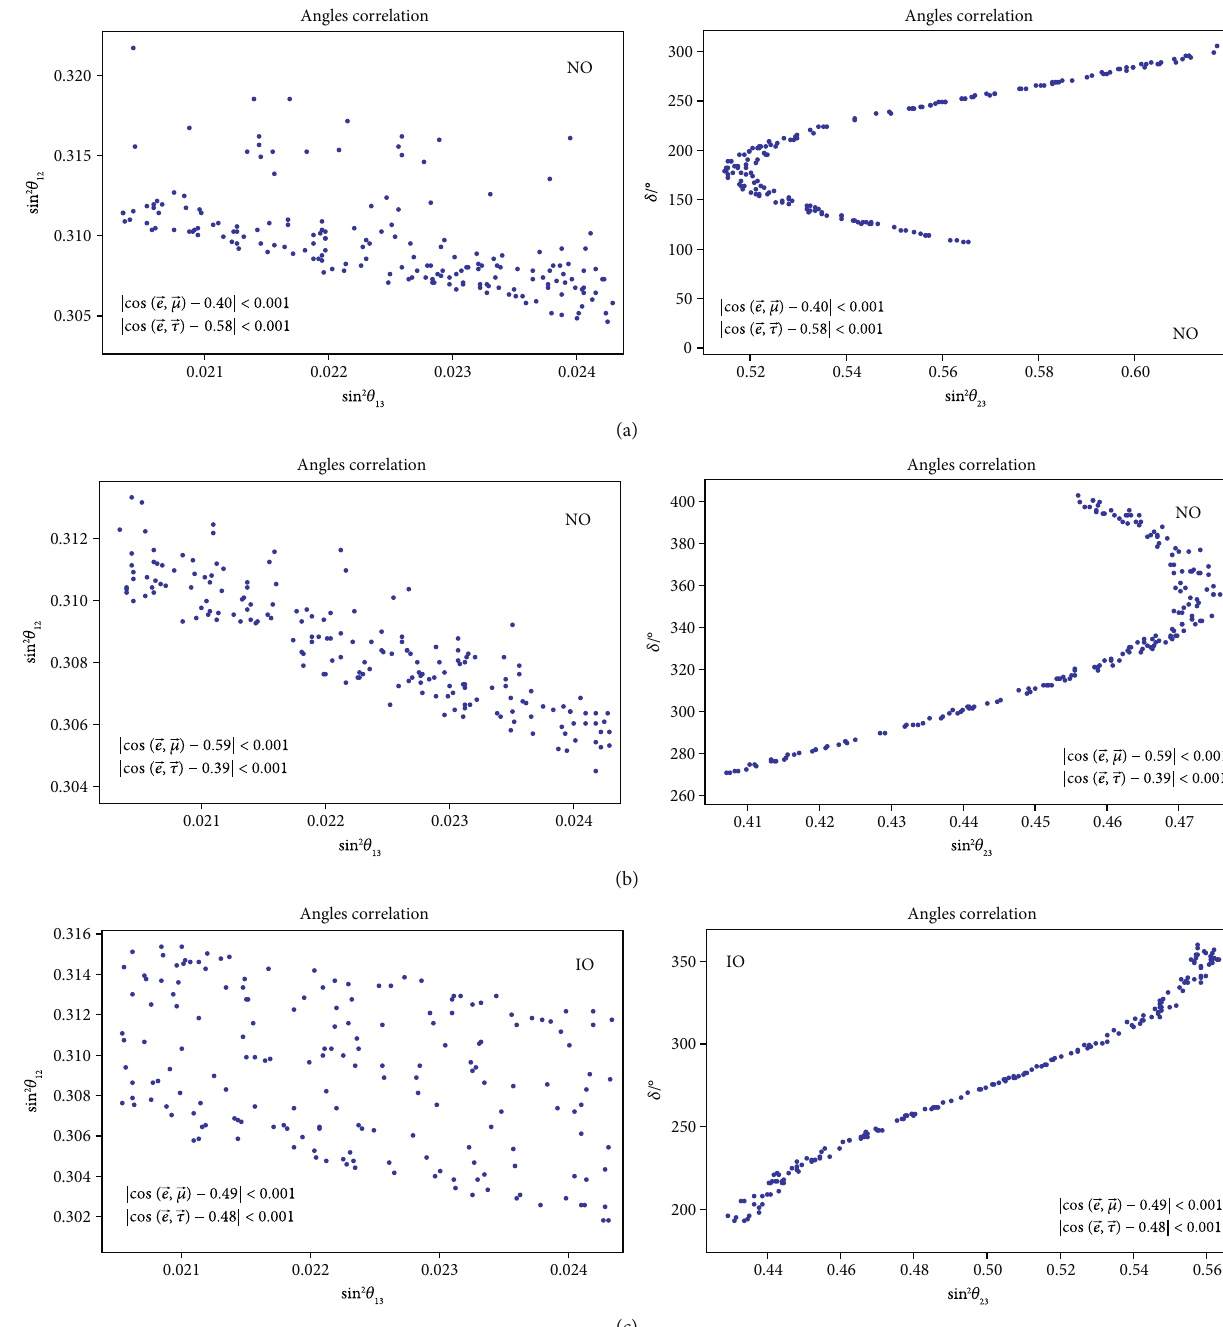
! Þ ! ! Þ ! ) listed in , μ , cos ð e , τ 0 0 0 0 ! Þ − ! , τ 0 : 58 j < 0 : 001 . (b) NO case with the constraints ! Þ ! ! Þ − ! , μ 0 : 49 j < 0 : 001 and j cos ð e , τ